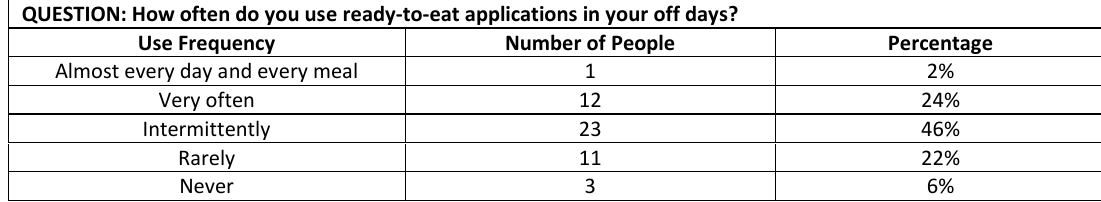
Table 3 Frequency of use of ready-to-eat applications by